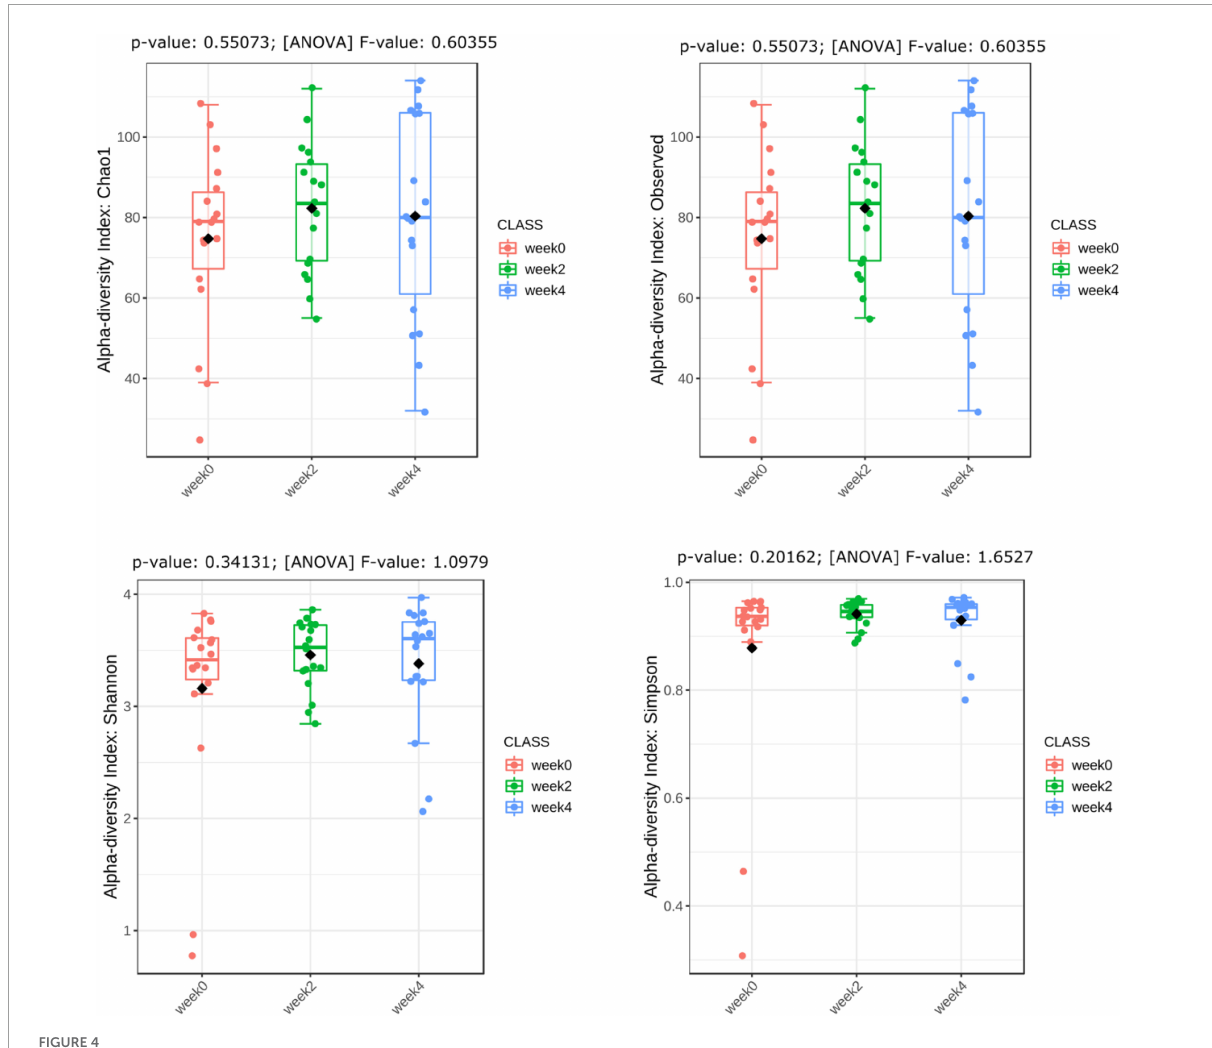
FIGURE4 Alpha diversity estimates in probiotic